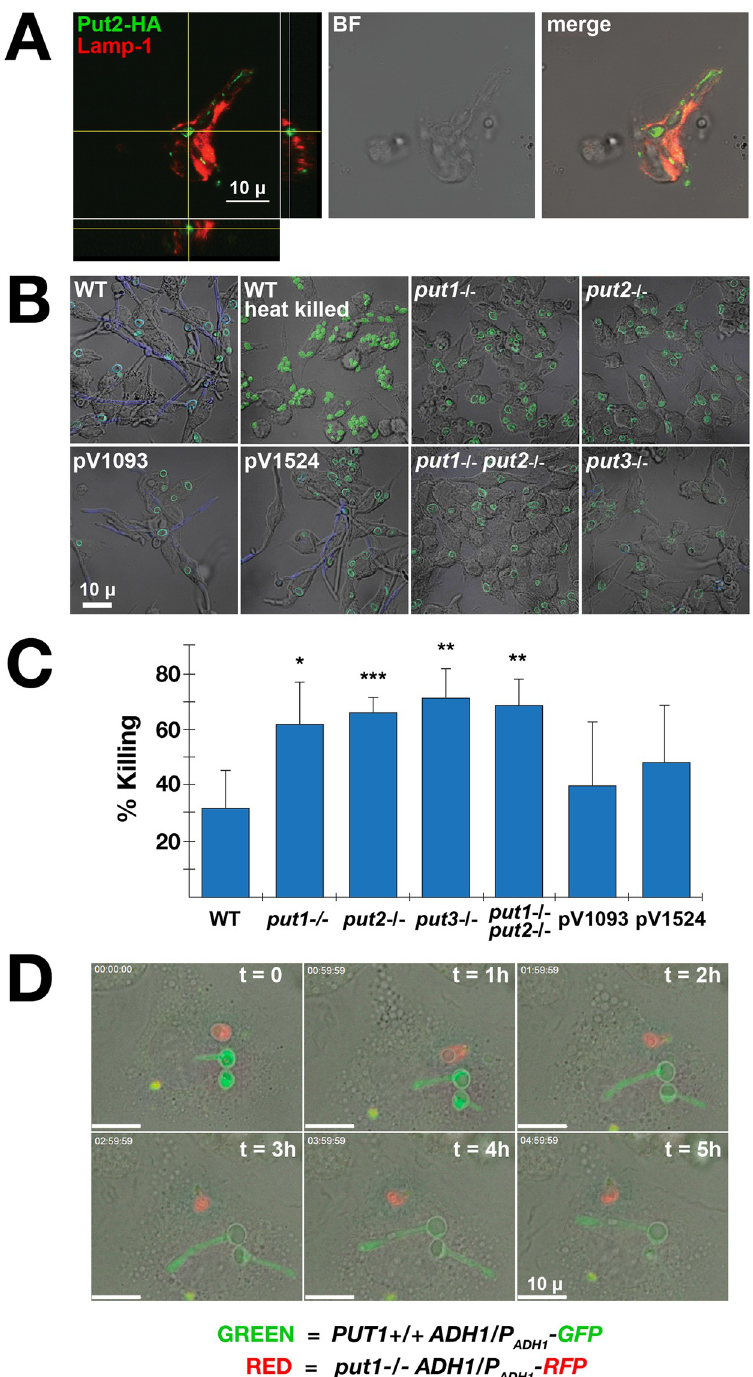
Fig 6. Mitochondrial proline catabolism is required by C . albicans cells to escape murine macrophages. A . Confocal immunofluorescence microscopy of C . albicans cells expressing Put2-HA (CFG185) in the phagosomes of RAW264.7 macrophages. Primary antibodies (rat anti-HA and rabbit anti-Lamp1) and secondary antibodies (Alexa Fluor 555 conjugated goat anti-rat antibody and Alexa Fluor 488 conjugated goat anti-rabbit) were used to visualize Put2 and the lysosomal compartment, respectively. Orthogonal view of merged channels is shown in the lower right panel. Scale bar = 10 μ . B . Proline catabolism is required for hyphal growth of C . albicans in macrophages. Wildtype (WT; SC5314), heat killed WT, put1 -/- (CFG139), put2 -/- (CFG207), put3 -/- (CFG146), put1 -/- put2-/- (CFG159) and CRISPR/Cas9 control strains CFG181 (pV1093) and CFG182 (pV1524) pre-grown in YPD and stained with